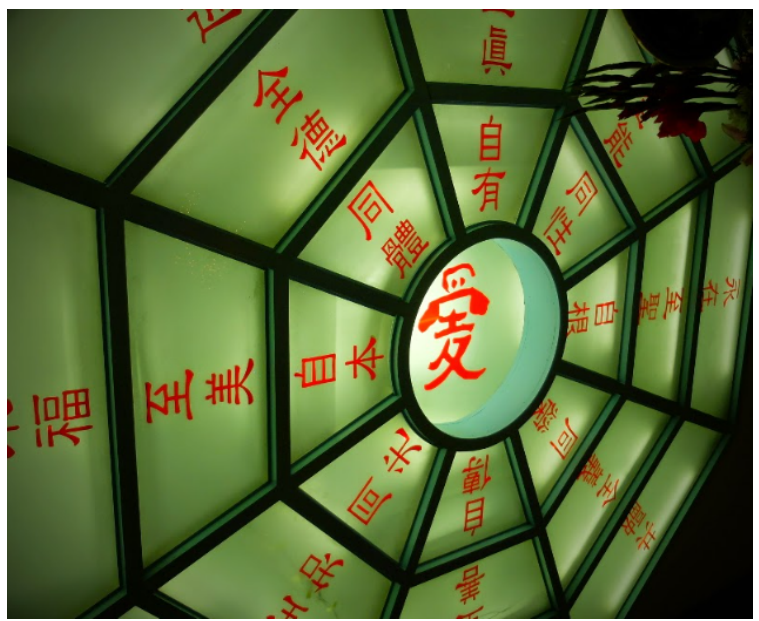
Figure 12. The Bagua inside the church of Saint Dominic in Taipei. At the center of Bagua is 愛 aì, the character for